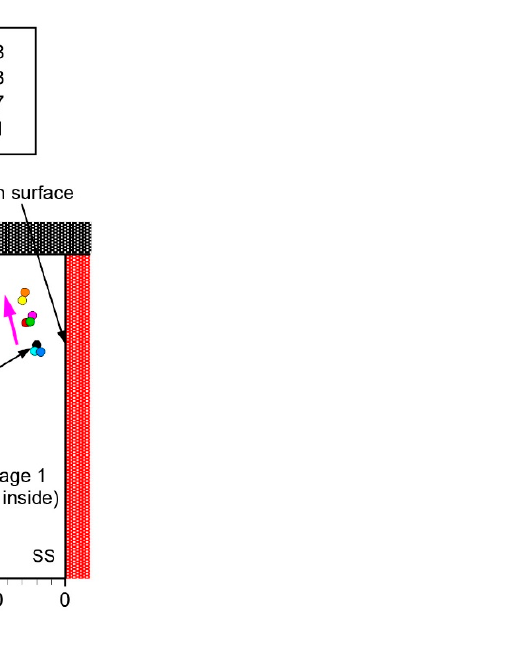
2. The movement of the vortex center in the Y -direction decreases as the plasma actuator is located further away from the blade leading edge, on both the upstream and down- stream sides. On the downstream side especially, the center location of the passage vortex at Z / C ax = − 0.51 is almost the same as the result for no control. In passage 3, shown in Figure 21c, when the installation location is further upstream than Z / C ax = 0.08, immedi- ately after the blade leading edge, the center location of the passage vortex remains almost constant, and its movement towards the upper endwall side reaches 59% at Z / C ax = − 0.20. However, at positions downstream of Z / C ax = 0.08, the amount of movement gradually decreases, and the position of the passage vortex becomes the same as that for no control. Figure 20. Center positions of passage vortex at various plasma actuator locations (Re out = 3.7 × 10 4 ).